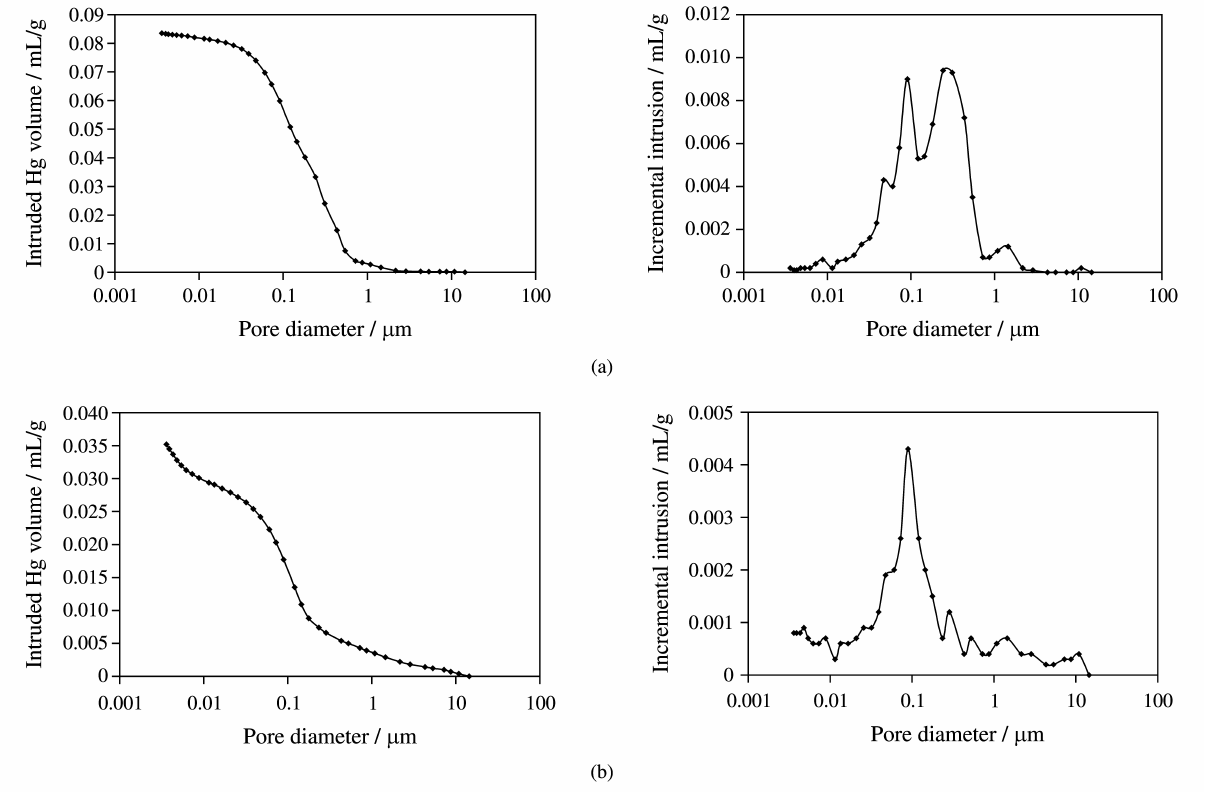
Figure 2. Intruded Hg volume vs. pore diameter curves and incremental intrusion vs. pore diameter curves, obtained from mercury intrusion porosimetry